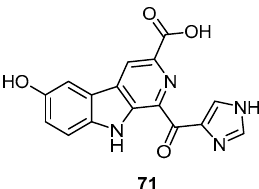
Figure 18. Chemical structure of hyrtiocarboline ( 71 ).